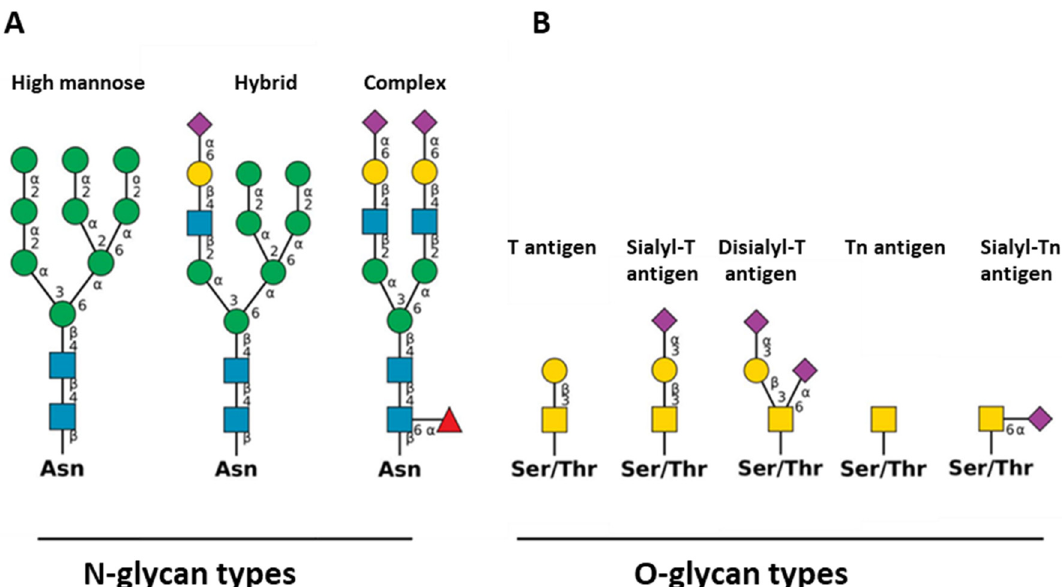
Figure 1. ( A ) N -glycan types: high mannose, hybrid, and complex. ( B ) O -glycan types: T antigen, sialyl-T antigen, disialyl-T antigen, Tn antigen, and sialyl-Tn antigen. Red triangle for fucose (Fuc); yellow circle for galactose (Gal); blue circle for glucose (Glc); yellow square for N -acetylgalactosamine (GalNAc); blue square for N -acetylglucosamine (GlcNAc); purple square for N -acetylneuraminic acid (Neu5Ac). Asn: asparagine; Ser/Thr: serine/threonine.